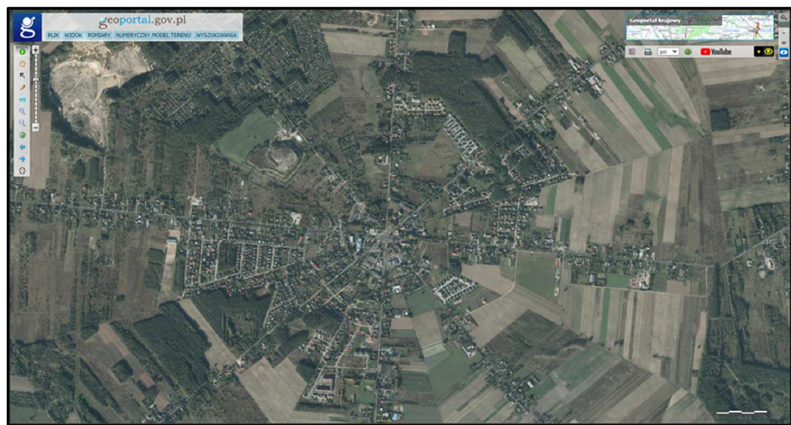
Figure 5. The satellite view of the examined Nowosolna cluster (source: [48]). The Nowosolna cluster is a rectangle region, 2.70 km by 3.90 km (approximately 1053 ha of land), characterized by a low density of buildings. The area is defined using a grid of cells, while the image is slightly rotated (only by approximately 7 degrees counterclockwise) to fit the visible streets pattern. The examined zone consists of 11.7 hundred parcels. It can be seen that the building distribution is non ‐ uniform and rather irregular; their placement was performed using an optical fitting. Additionally, it is taken into account that the center of this region consists of several public buildings (school, church, shops); thus, this part of the area was not considered. The schema of the examined BEC is presented in Figure 6; it consists of 1098 single ‐ family houses, which is only 9.4% of all available cells.